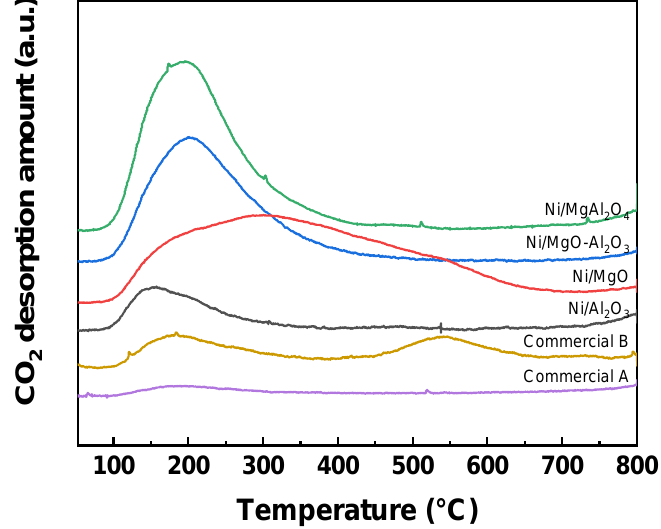
Figure 3. CO 2 -TPD profiles of Ni catalysts with various supports.